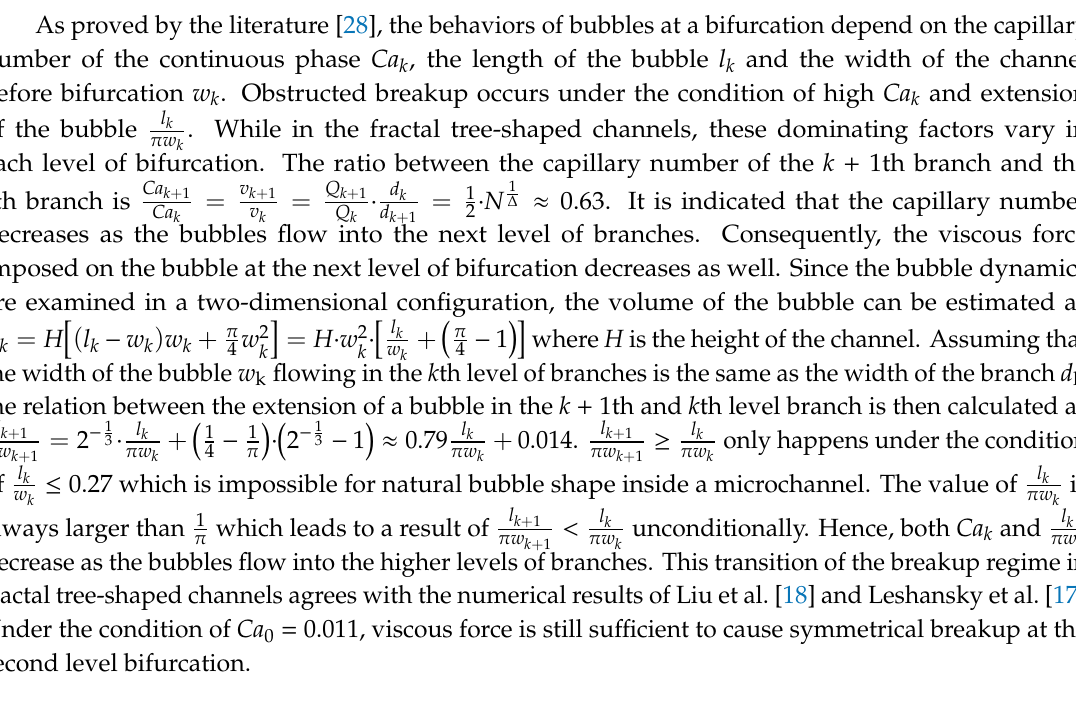
Figure 3. Bubble breakup at the second bifurcation of the fractal tree-shaped microchannel (Ca 0 =